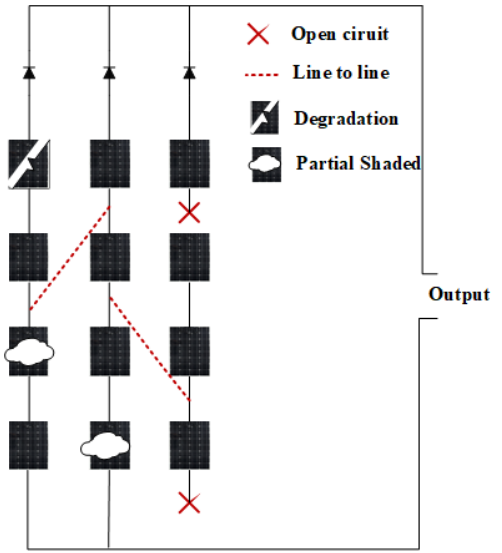
Figure 2. Schematic structure of different